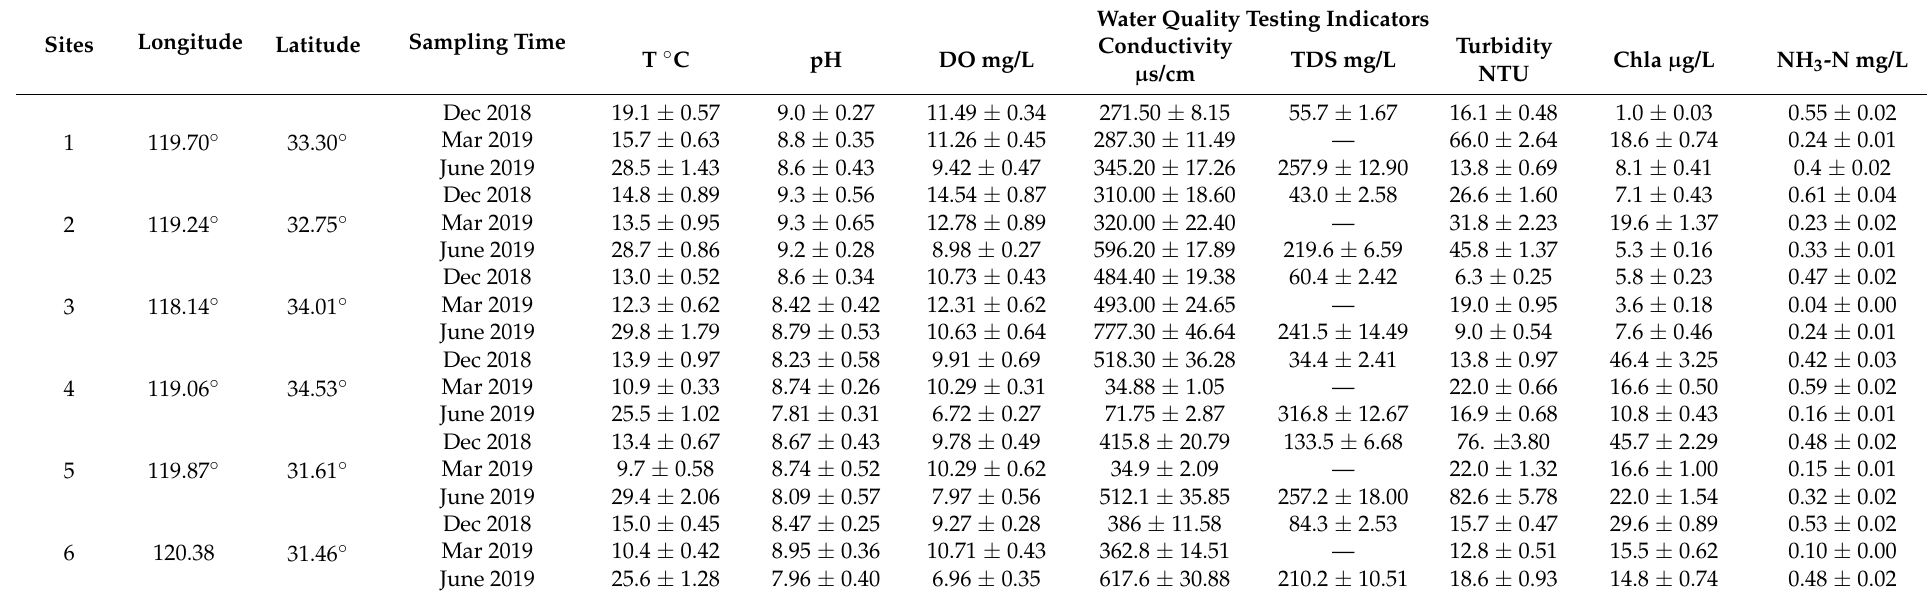
Table 2. Water source water quality of sampling